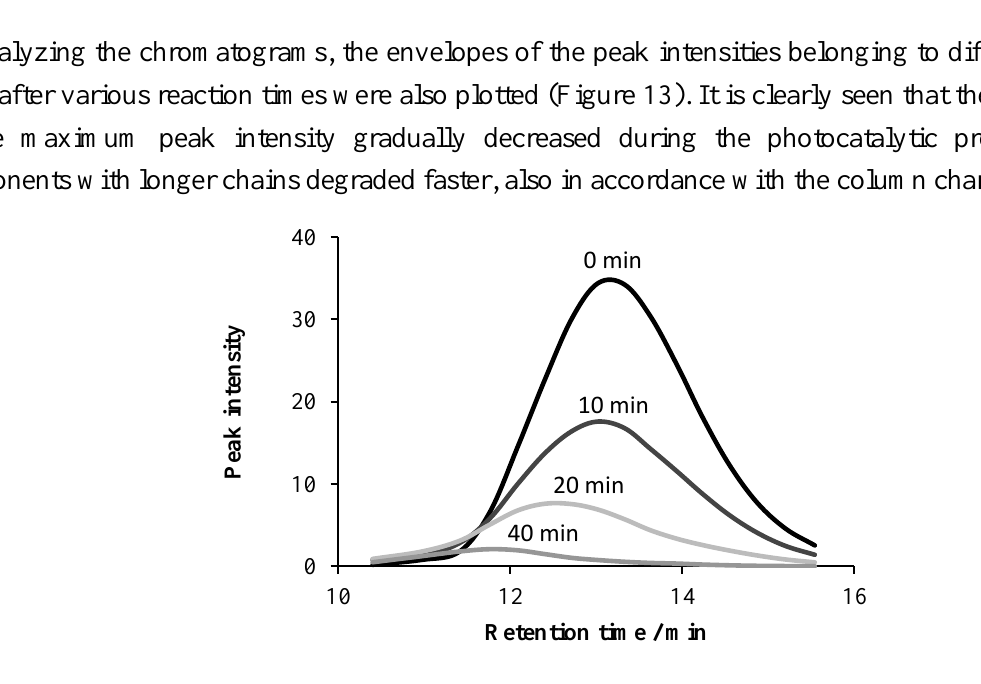
Figure 13. The peak intensity as a function of the retention time, taken from the UHPLC chromatograms during the photocatalysis of the system containing 2 × 10 −4 mol·dm −3 Triton X-100 and 1 g·dm −3 TiO 2 , after 0, 10, 20 and 40 min of reaction